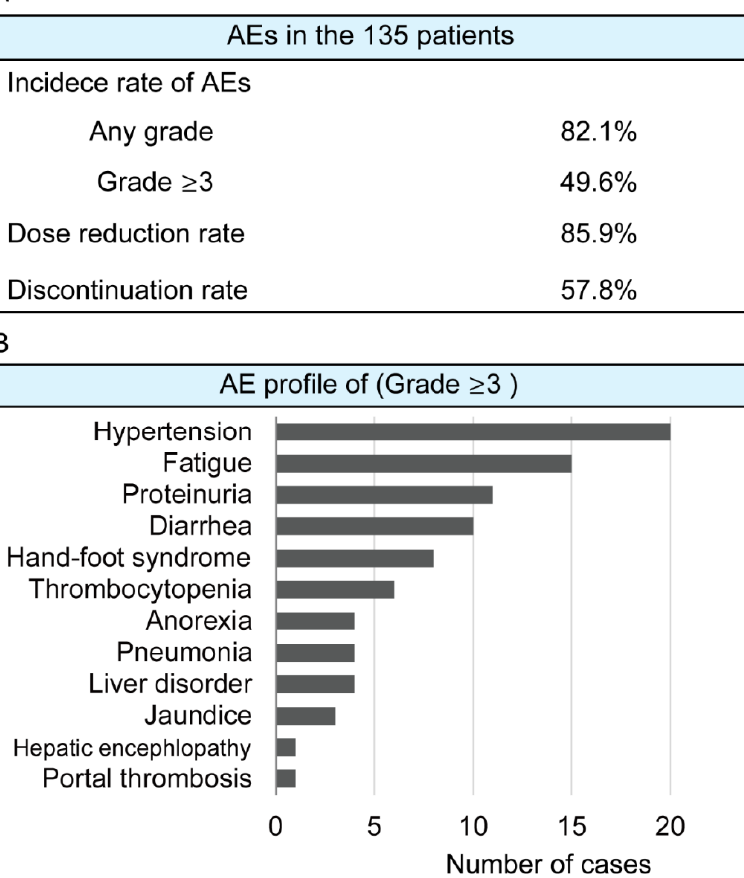
Figure 1. Adverse events of lenvatinib treatment. ( A ) Incidence rate, dose reduction rate, and treatment discontinuation rate. ( B ) Profile of adverse events. AE: adverse event.